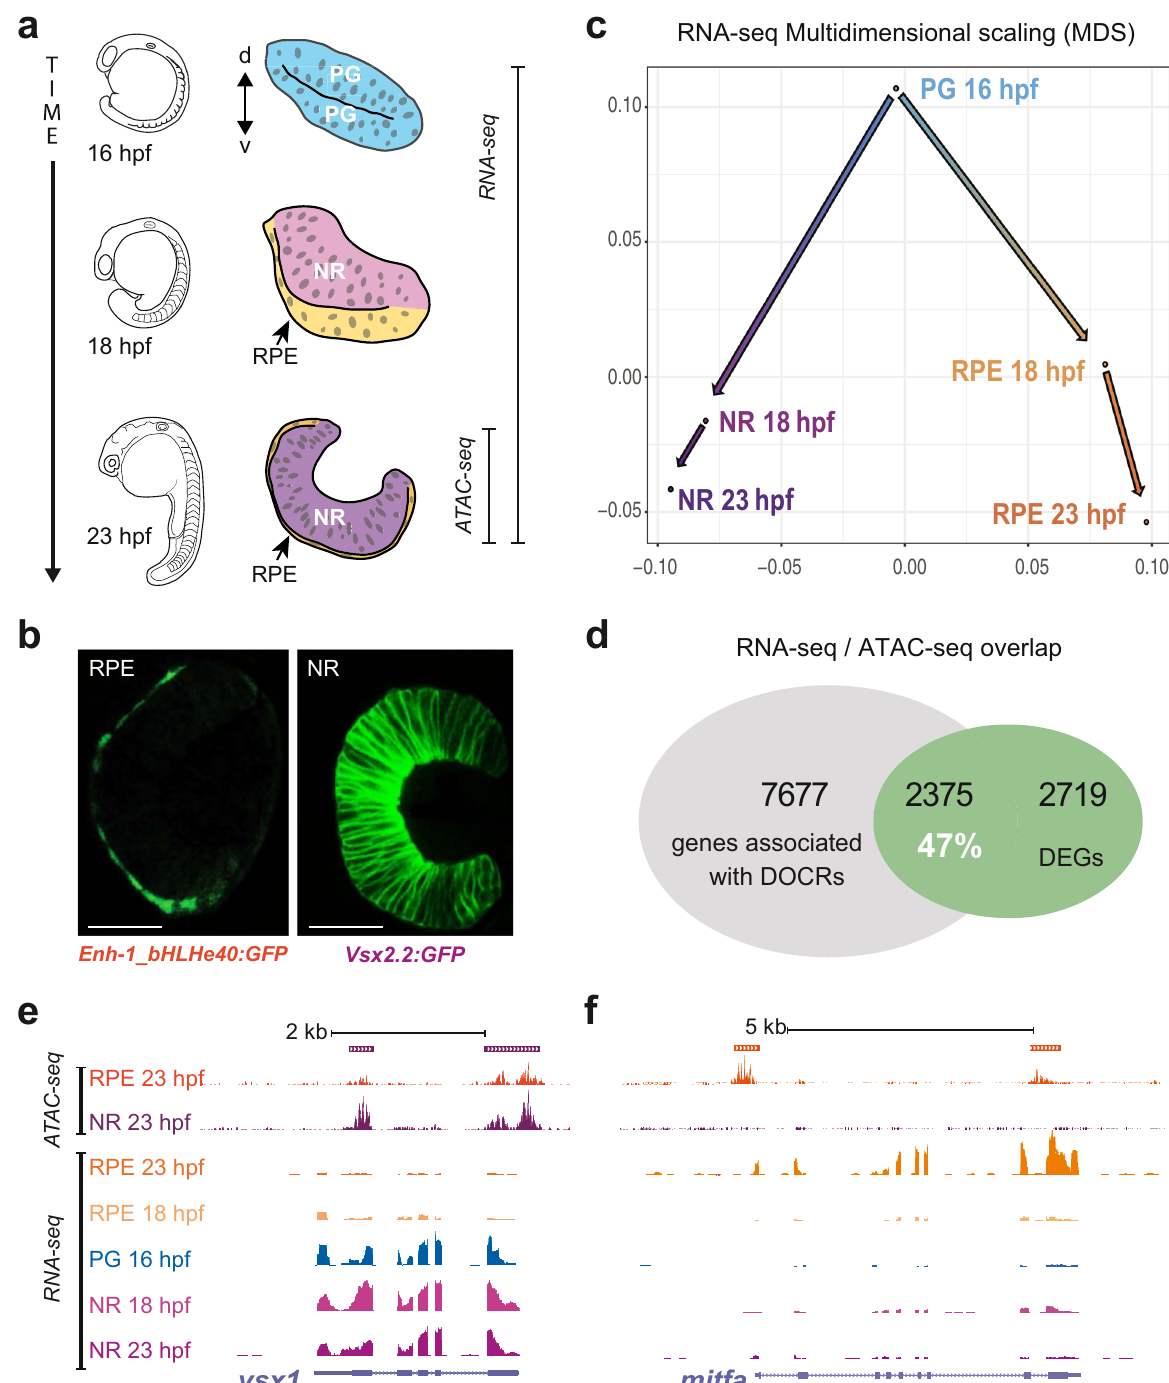
Fig. 1 Experimental setup and raw data. a Schematic representation of optic vesicle morphogenesis from undifferentiated retinal progenitor cells (PG, blue), at 16 hpf, to segregation and differentiation of the neural retina (NR, purple) and pigmented epithelium (RPE, orange) domains at 18 and 23 hpf. NR and RPE populations isolated by fl ow cytometry were analyzed by RNA-seq and ATAC-seq at the stages indicated. b Stage 23 hpf confocal sections from the zebra fi sh transgenic lines used to mark and isolate the RPE ( E1_bHLHe40:GFP ) and NR ( vsx2.2:GFP ) populations. Bar = 50 µ m. c Multidimensional scaling analysis of the RNA-seq data showing a progressive transcriptomic divergence between the NR and RPE domains. d Percentage of overlapping between differentially expressed genes (DEGs) and genes associated with differentially opened chromatin regions (DOCRs). e , f Overview of ATAC-seq and RNA-seq tracks (UCSC browser) for representative NR ( vsx1 ; ( e )) and RPE ( mitfa ; ( f )) speci fi c genes. Solid bars on the top indicate DOCRs. If purple, the DOCR is more accessible in the NR. On the contrary, if orange, the DOCR is more accessible in the RPE. In the depicted case all the DOCRs are accompanied by increased transcription of the associated gene in the corresponding